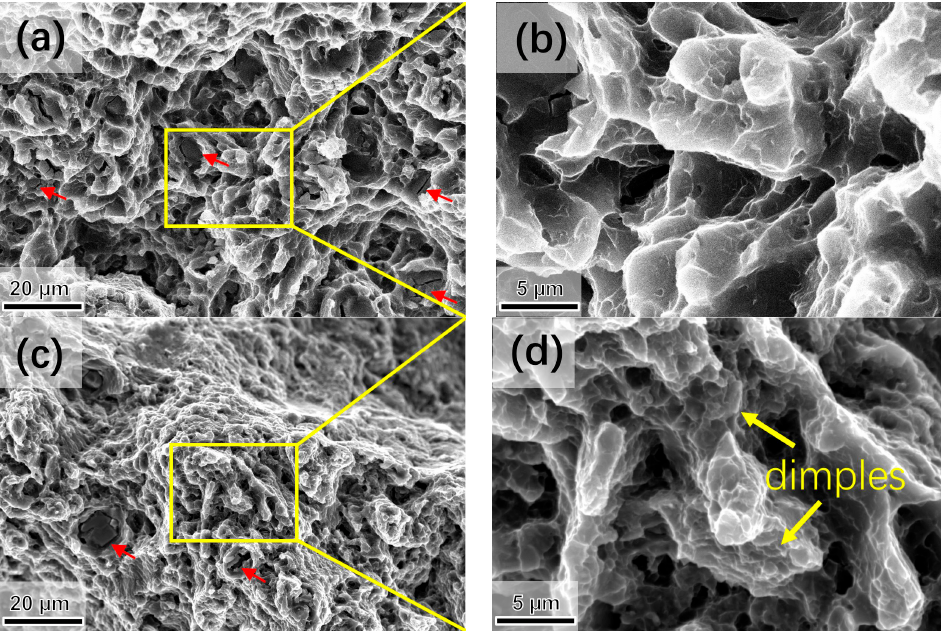
Figure 10. SEM fracture morphology of ( a , b ) as-extruded and ( c , d ) CRed AZ80 alloy after tensile test to failure.